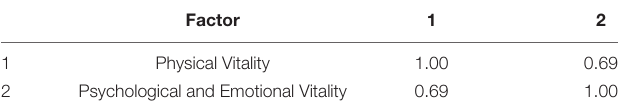
TABLE 3 | Exploratory factor analysis: matrix of factor correlations of the